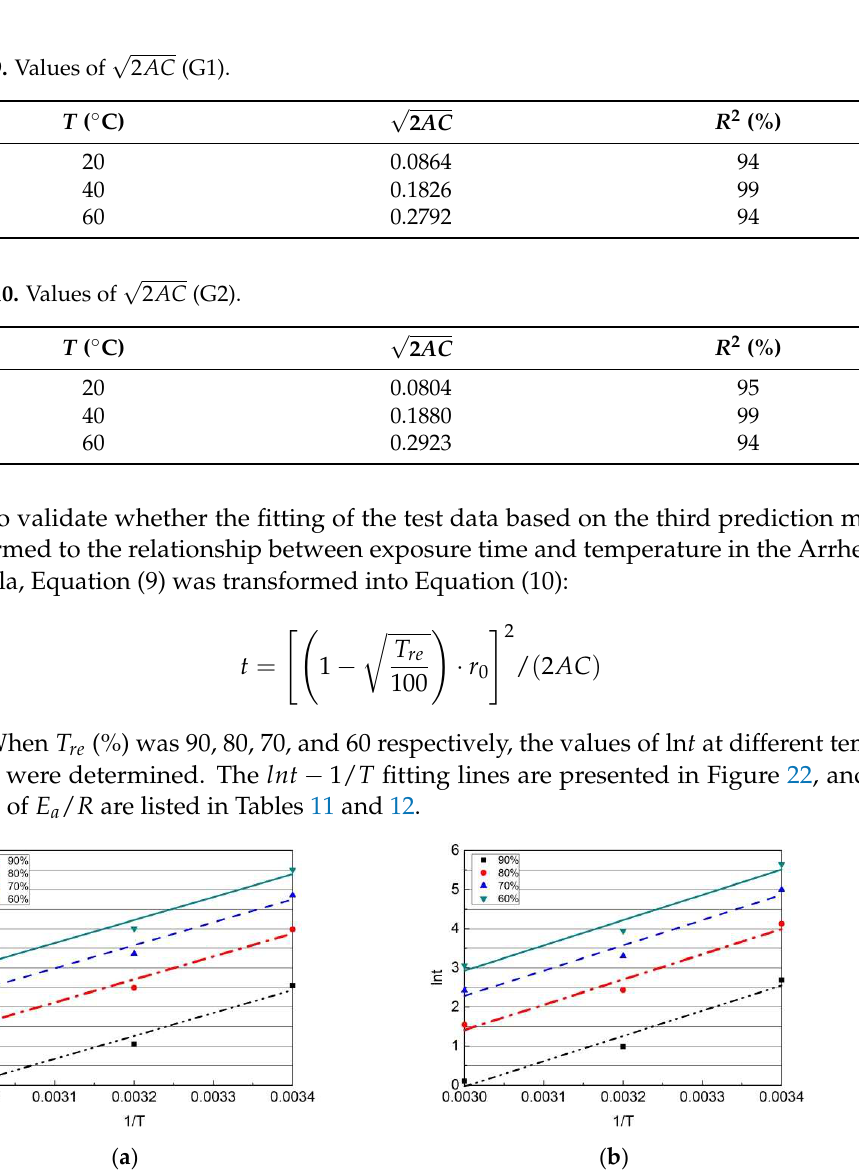
Table 9. Values of